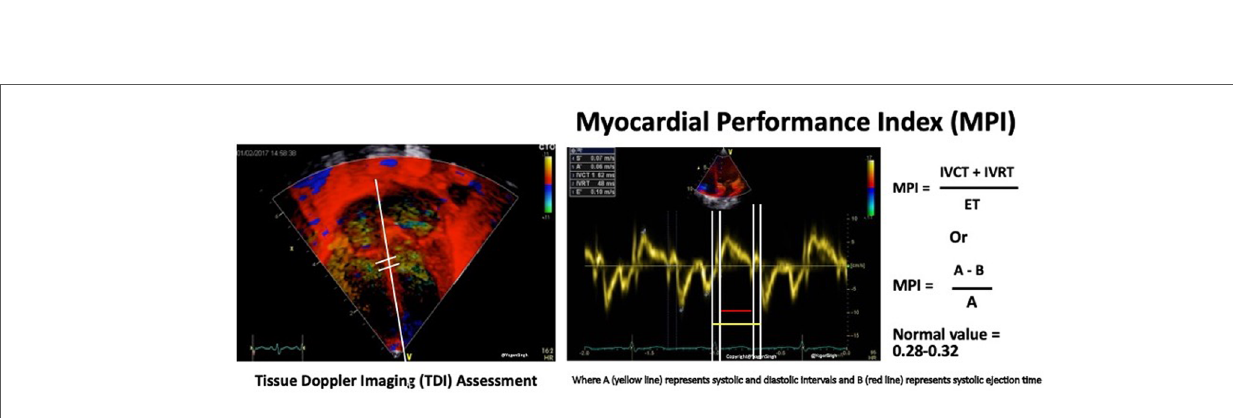
FIGURE 6 Tissue Doppler imaging (TDI, left ) assessment of myocardial performance index (MPI, right